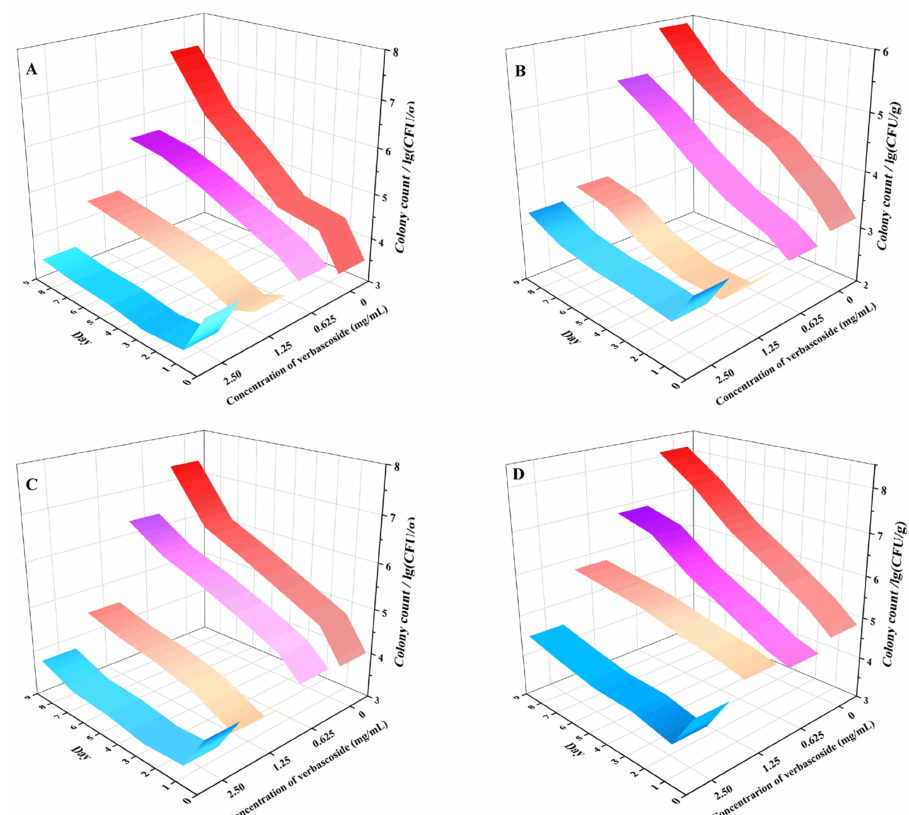
Figure 7. Changes in the number of colony-forming units in different meat samples during refrigeration with verbascoside treatment at various concentrations. ( A ) Chicken. ( B ) Beef. ( C ) Tuna. ( D )